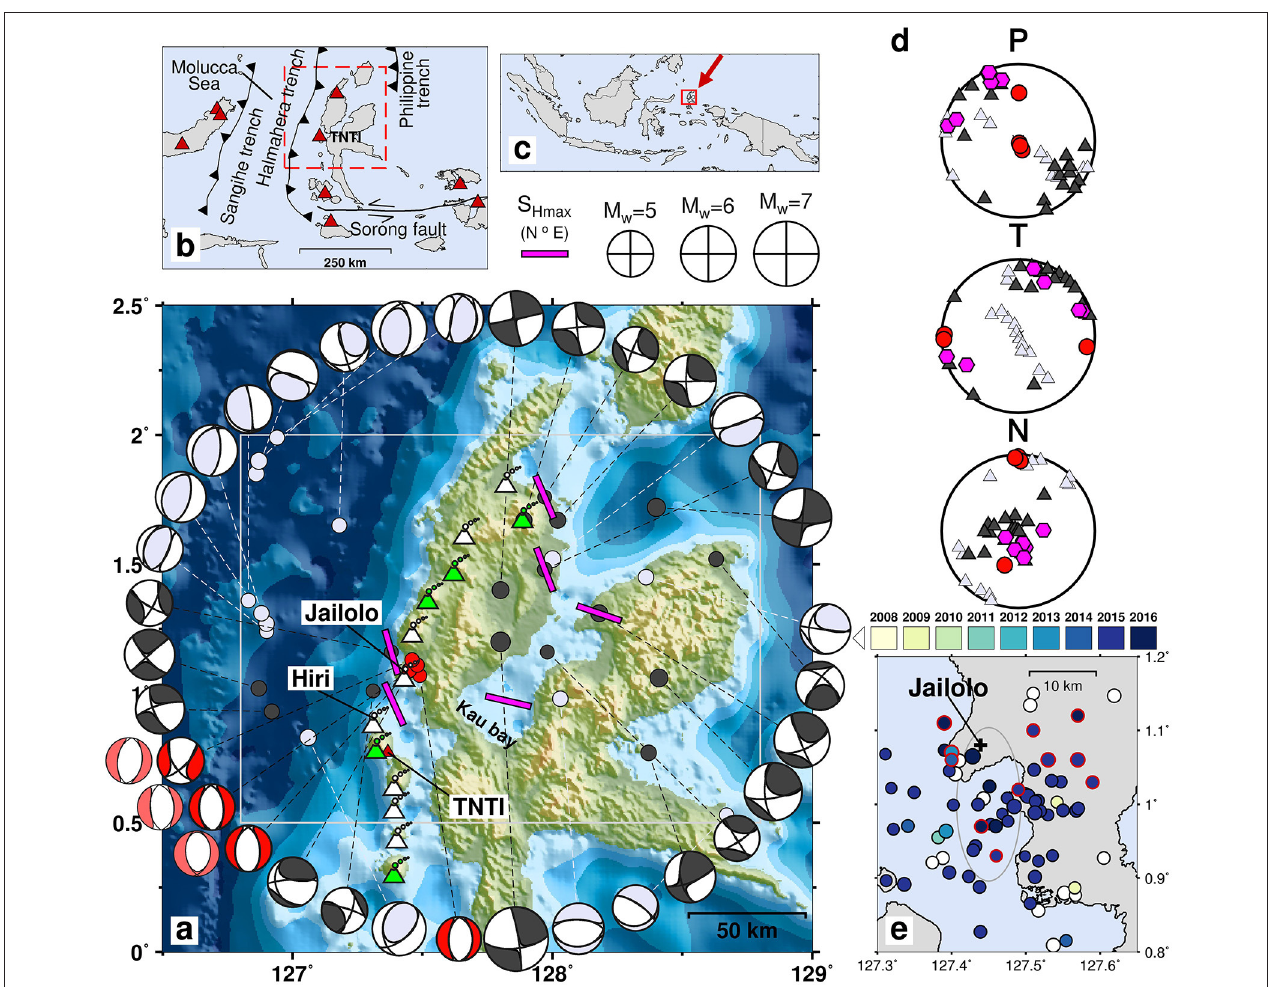
FIGURE 1 | Map of Halmahera, tectonics, and strain/stress field. (a) Map of northern part of Halmahera island with topography and bathymetry from GEBCO_2014 grid version 20150318, www.gebco.net ( Weatherall et al., 2015), where the highest and lowest points are 1,550m a.s.l. and − 3,550m b.s.l., respectively. Colored circles are the epicenters of the FMs reported in the GCMT catalog, selected within the region indicated by the light gray box and with < 50km hypocentral depth. Dark gray beach balls have P- and T-axes plunging < 45 ◦ . Light red beach balls are the four largest events that occurred during the November 2015 – February 2016 seismic swarm at Jailolo volcano, which are paired with the available pale red FMs listed in the GEOFON earthquake catalog. Light gray beach balls are the remaining FMs. Beach ball and epicentral circle sizes scale with magnitude as shown in the legend. Magenta bars indicate the azimuth and location of the maximum horizontal stress S Hmax listed in the World stress Stress Map. Volcanoes are indicated with volcano symbols: green-colored symbols indicate Holocene eruptions while white-colored symbols indicate unknown Holocene eruptions (Global Volcanism Program). The red triangle shows the TNTI seismic station. (b) Larger map indicating the main regional tectonic structures of the Molucca Sea and Halmahera region. Red triangles are the seismic stations of the Indonesian (IA) and GEOFON (GE) networks used in this study. The red box indicates the area plotted in (a) . (c) Map of Indonesia highlighting the Halmahera region plotted in (a) . (d) Stereographic plot of the P-, T-, and N-axes of the FMs and the regional stress field as color-coded in panel (a) . Triangles are the strike-slip (gray) and other FMs (light gray), red circles are the FMs of the Jailolo seismic swarm, and magenta hexagons are the stress axis orientation from the World Stress Map database. (e) Seismicity in the epicentral area of the 2015–2016 swarm at Jailolo (gray ellipse) listed in the USGS ANSS (black outlined circles) and GEOFON (red outlined circles) catalogs with hypocentral depth shallower than 50km. The color code is the year from 2008 and the symbol size scales with magnitude as in (a) .